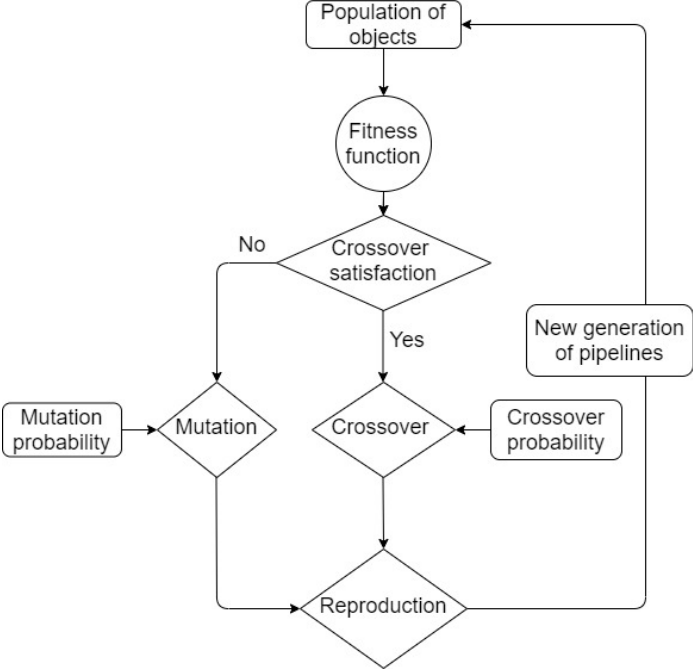
Fuels 2021 , 2 , FOR PEER REVIEW Figure 5. Schematic of genetic programming. Figure 5. Schematic of genetic programming.